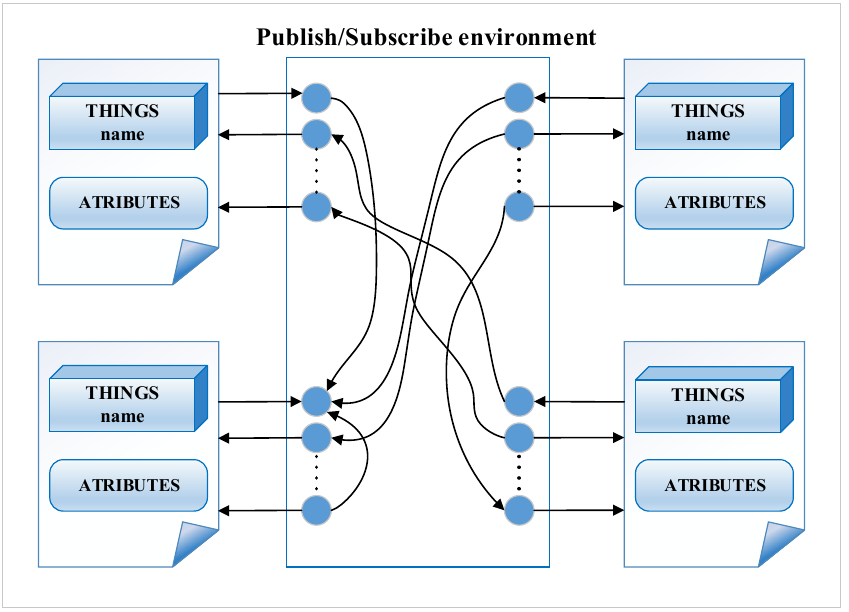
Figure 5. Interactions between things in a publisher-subscriber communication environment.